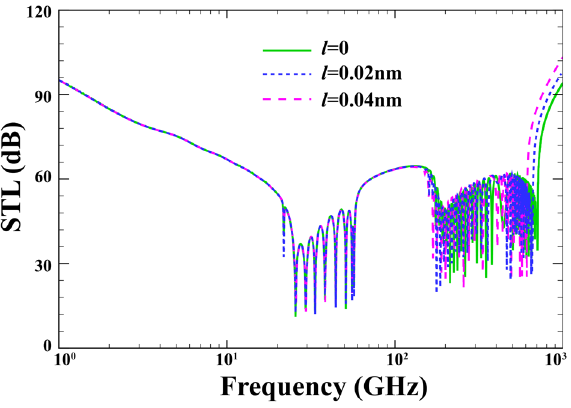
Figure 12. Effect of the strain gradient parameter on the changes of